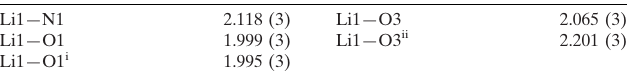
Selected bond lengths (A˚